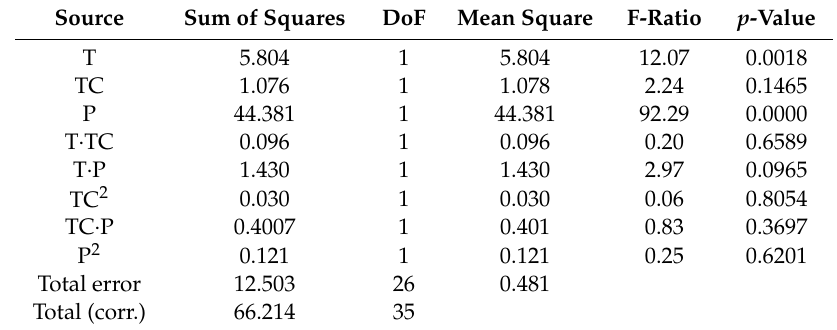
Figure 5. Estimated response surface for the mechanical durability index considering the process temperature and the proportion of rice husk in the biomass mixture for a compaction time of 40 s. 3.3. Results for Compressive Strength Table 8 shows the results of compressive strength tests. The standard deviation (SD) for each experimental treatment is shown in the right column. Table 8. Results for compressive strength in rice husk and pine sawdust briquettes. Treatment